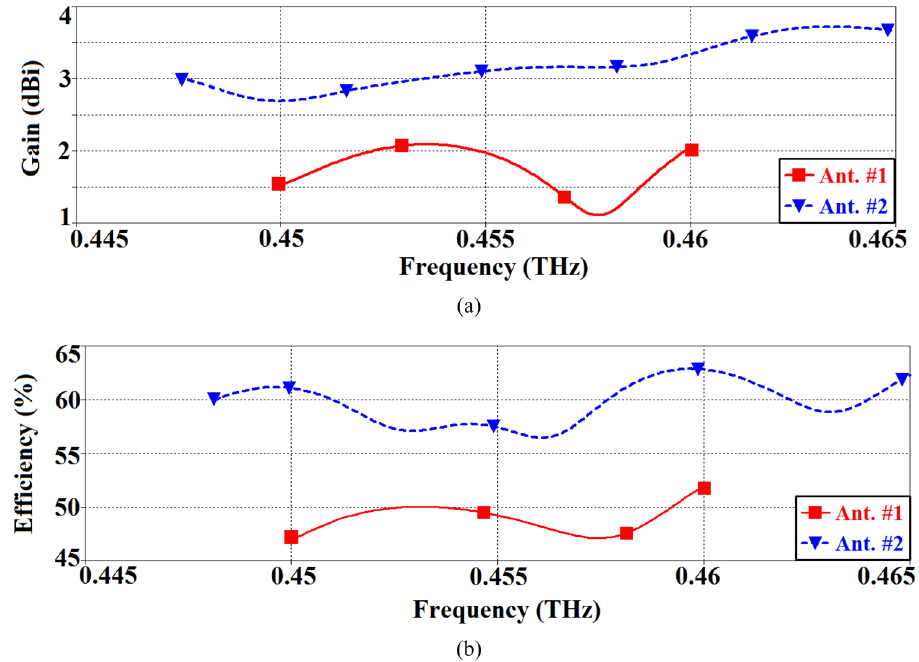
Figure 7. Antenna gain and radiation efficiency of Ants. #1 and #2 over their operating frequency